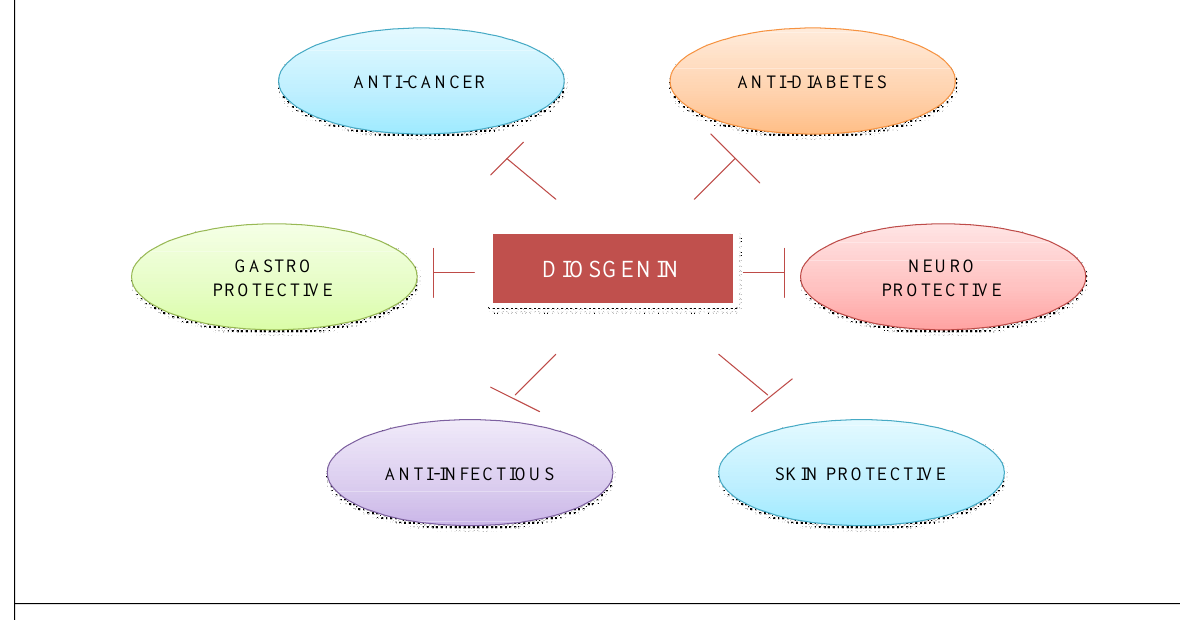
Figure 2: Pharmacological properties of diosgenin